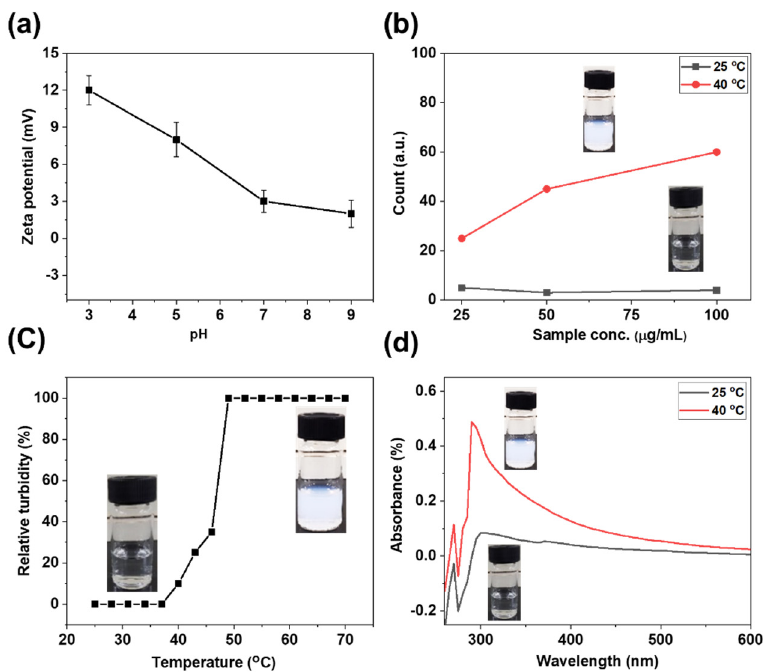
Figure 3. pH and thermo-responsive behavior of PNIPAm-co-PAAm HG. ( a ) Zeta potential and ( b ) particle size of PNIPAm-co-PAAm HG sample. ( c ) Relative turbidity of PNIPAm-co-PAAm HG sample (10 mg/mL) at 25 °C and 40 °C. ( d ) UV–vis absorption of PNIPAm-co-PAAm HG sample (10 mg/mL) at 25 °C and 40 °C.